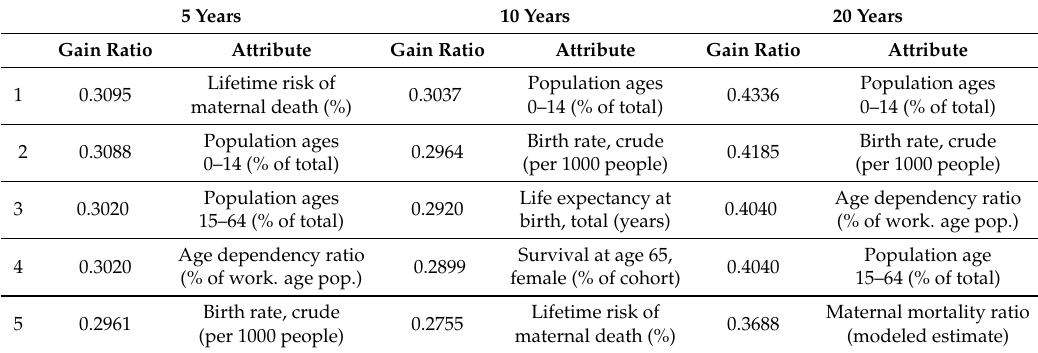
Table 4. The five attributes with the highest information gain ratio for forecasts over three different time